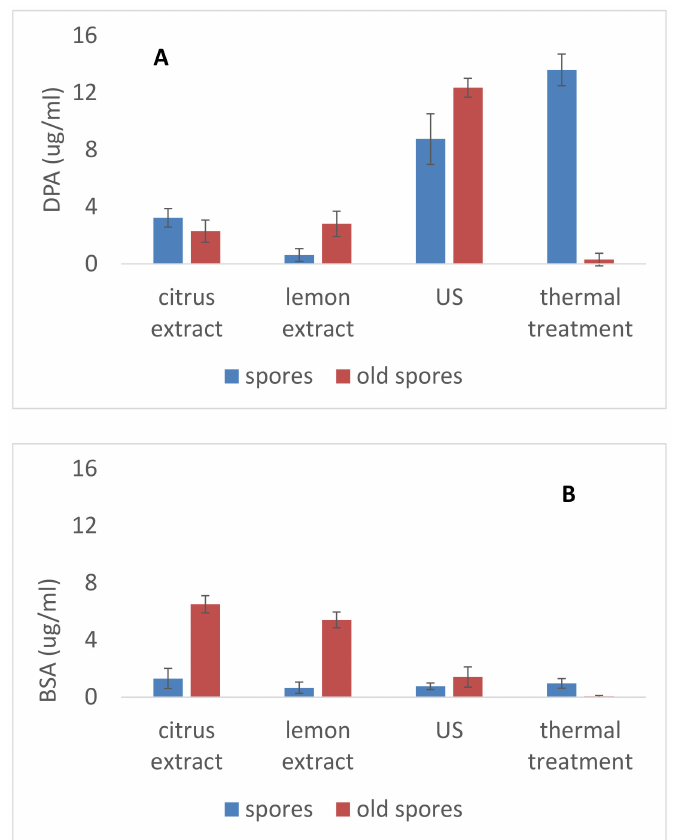
Figure 3. Dipicolinic acid (DPA) ( A ) and protein release (bovine serum albumin (BSA), ( B ) from B. coagulans spores immediately after the treatment. Mean ± standard